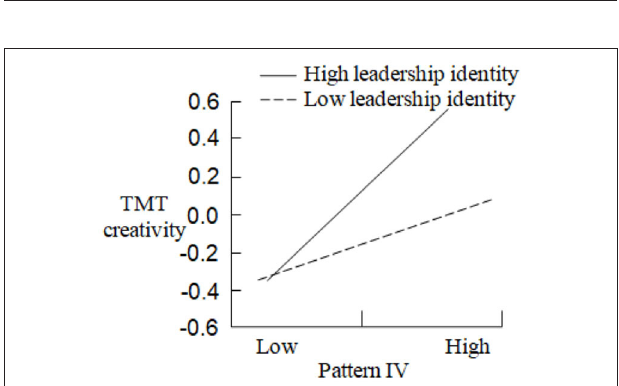
FIGURE 5 | The moderating effect of leadership identity in the relationship between pattern IV and TMT